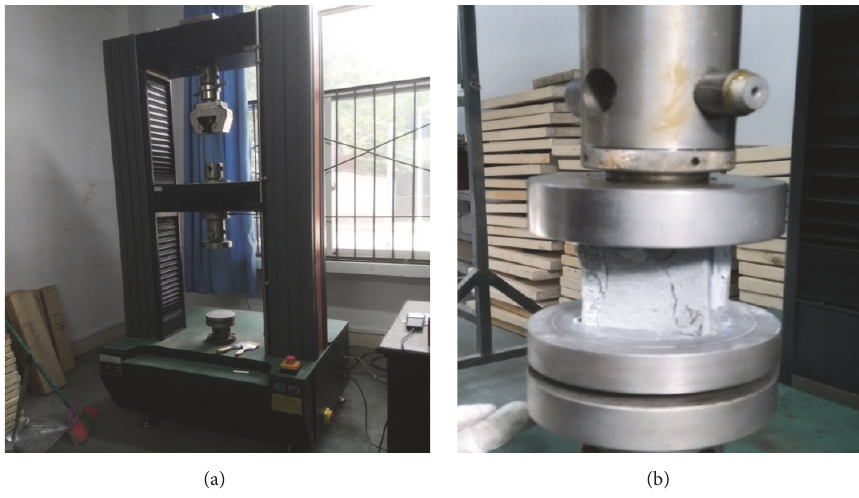
Figure 2: (a) Experimental facility. (b) Uniaxial compression fixture for cement pastes.